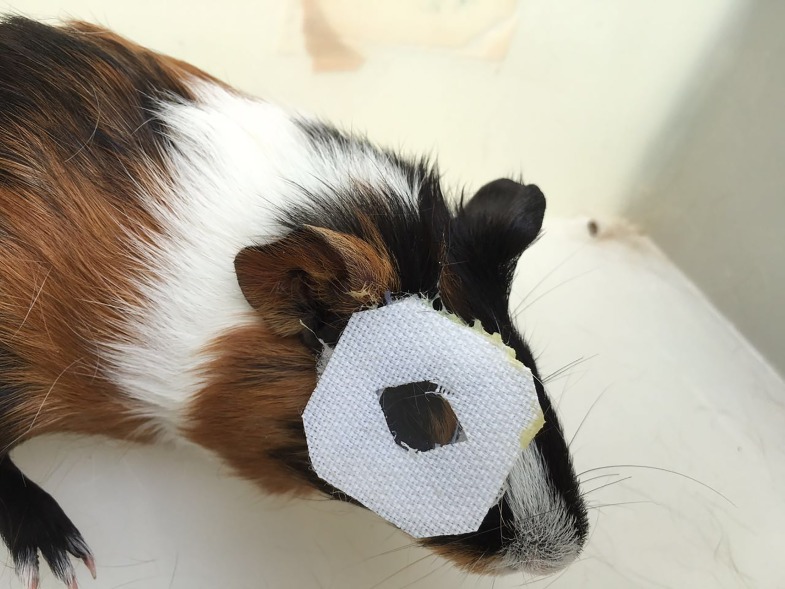
A guinea pig with the defocussing optic in place.